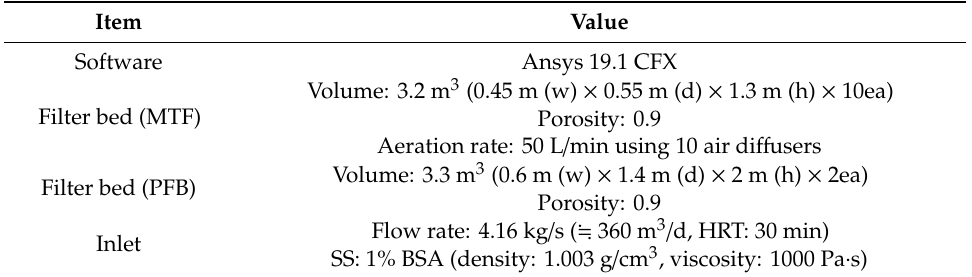
Table 2. Analytical conditions of MTF and PFB using computational fluid dynamics (CFD)